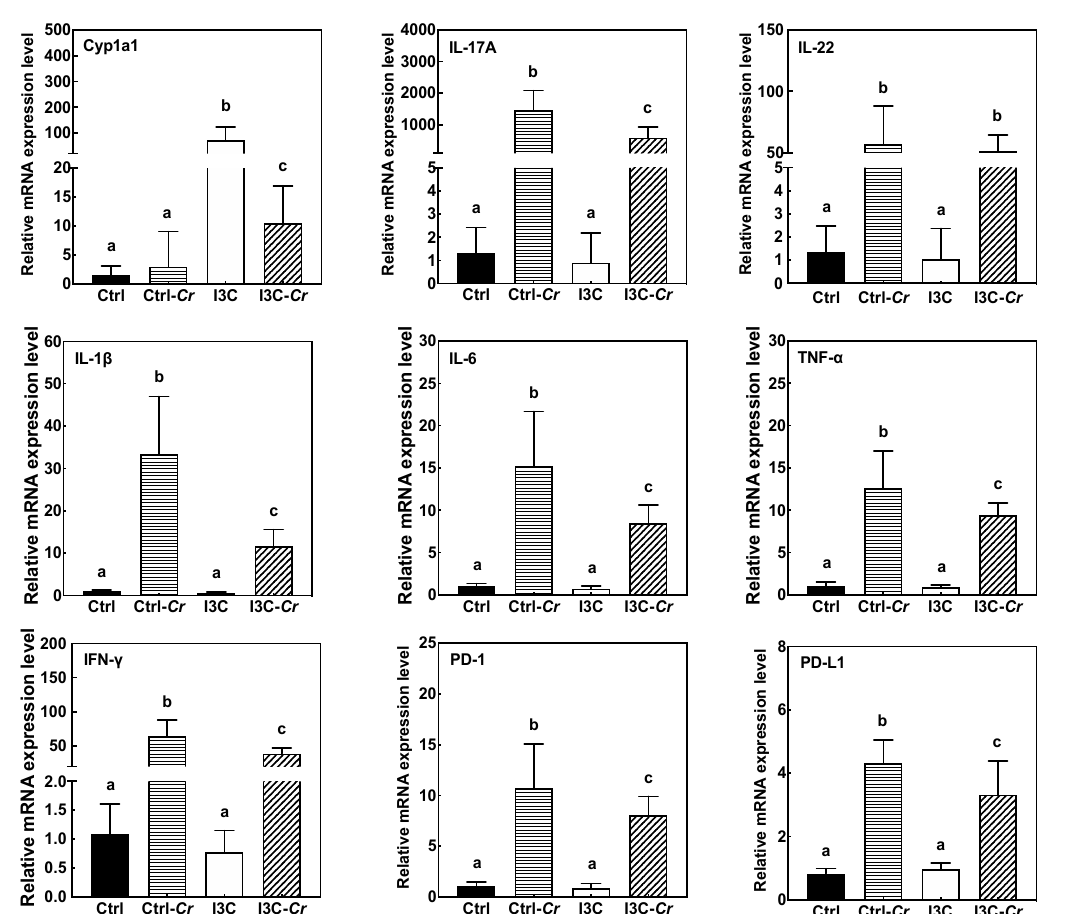
Figure 5. I3C significantly increased xenobiotic metabolizing enzyme genes (Cyp1a1), and attenuated inflammatory markers (IL17A, IL6, IL-1 β , TNF- α and IFN- γ ) and immune checkpoint inhibitors (PD-1 and PD-L1) gene expression in the colon of infected mice, while it has no e ff ect on Cr-induced increase of IL-22 mRNA. RT-PCR was performed on total RNA isolated from colon tissues harvested on day 12 post-infection. Results are expressed as the mean +/ − SD fold-change (n = 8). Ctrl: control diet; Ctrl-Cr: control diet, Cr-infected; I3C: I3C diet; I3C-Cr: I3C diet, Cr-infected. Significant di ff erences ( p < 0.05) between groups are identified by di ff erent letters.